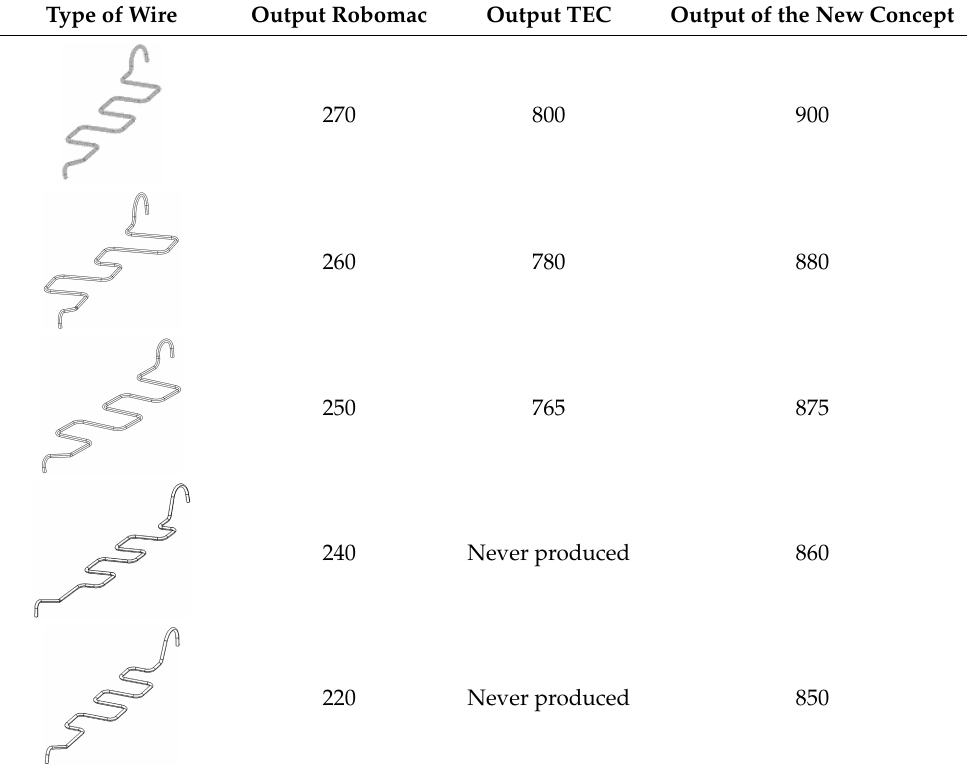
Table 3. Productivity analysis regarding the different considered